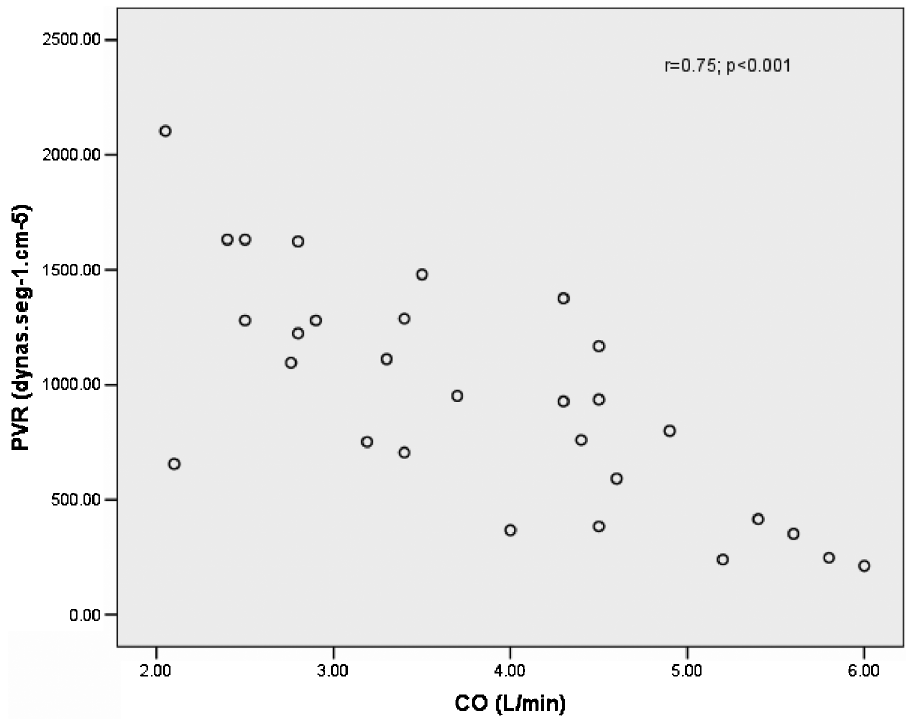
Figure 2 - Linear regression of CO and